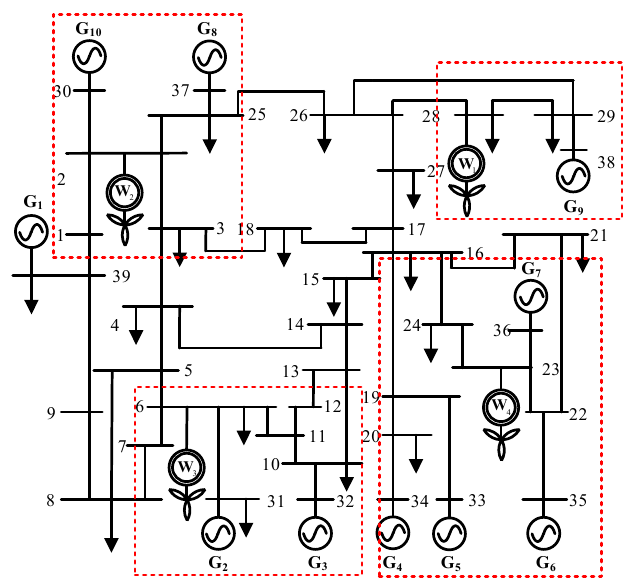
Figure 6. The modified IEEE 39-bus system.